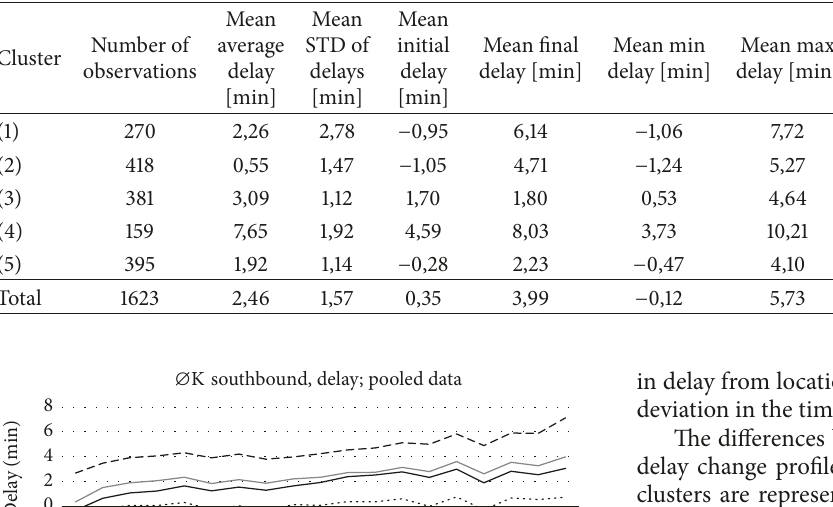
Table 4: Characterization of delay profile clusters and southbound ØK trains, Niv˚a–Copenhagen.